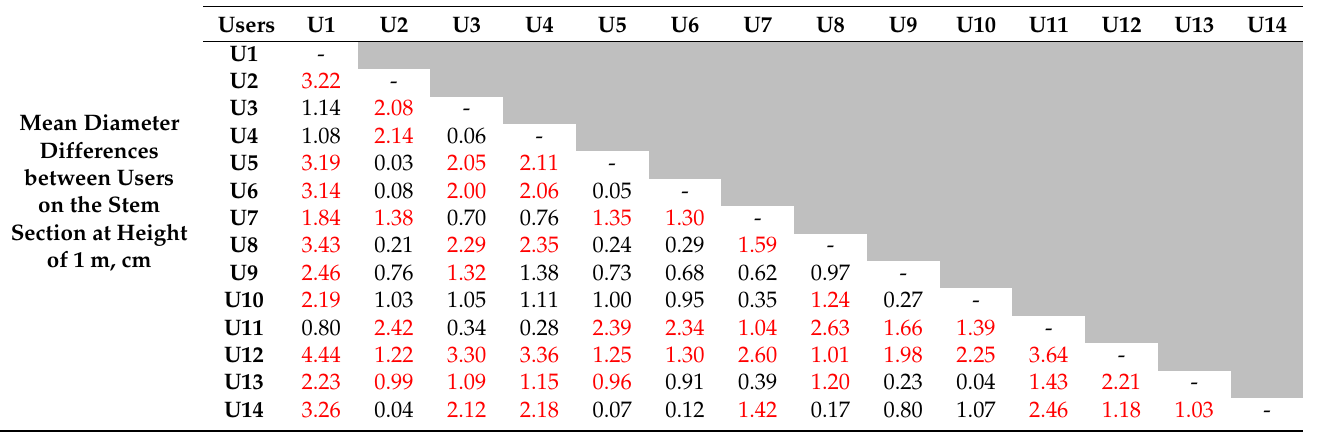
Table A1. Differences between mean diameters obtained by each user when a laser caliper was used to measure upper-stem diameters at a height of 1 m. The red values denote significant differences between the mean diameters obtained by the